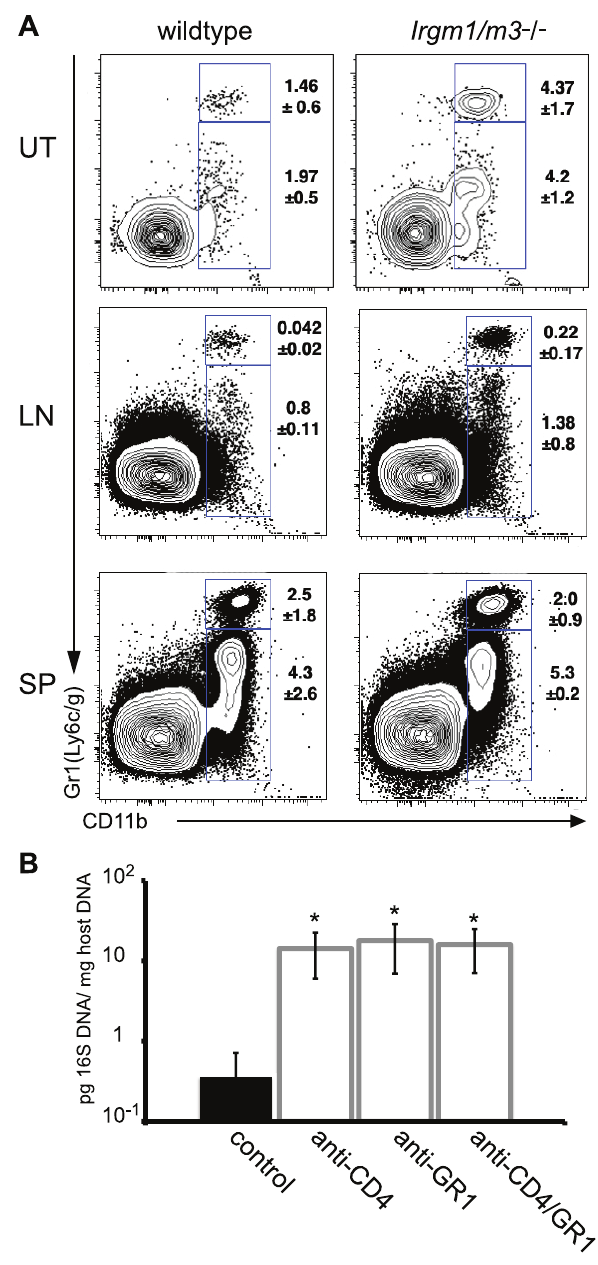
Figure 8. A neutrophil surge into the uterus of C.trachomatis - infected Irgm1/m3 (-/-) mice plays a role in immune clearance. ( A ) Wildtype or Irgm1/m3 (-/-) mice were transcervically infected with C. trachomatis . Fifteen days later, the uterus (UT), iliac lymphnodes (LN), and spleens (SP) of these mice were assessed for lymphocyte populations via FACS analysis. Macrophage populations were gated via CD11b + GR1 low , while neutrophil populations exhibited a CD11b + GR1 high phenotype. Average percent of total is represented on the right of the gated population + /- standard deviation. Neutrophil populations in uteri and lymph nodes were statistically different between wildtype and Irgm1/m3 (-/-) mice (p , 0.05). (B) Irgm1/m3 (-/-) mice were treated with depleting antibodies as described in Materials and Methods and 15 days post-infection bacterial burden in the spleen was measured by qPCR. Significant increases in bacterial burden in antibody-treated Irgm1/m3 (-/-) mice compared to mice treated with an isotype control antibody are indicated (*, p , 0.05). The data are representative of two independent experiments.